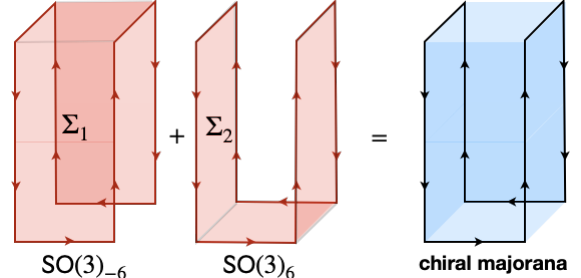
-symmetric 4 z -symmetric pattern of SO ( 3 ) topo- 4 z 6